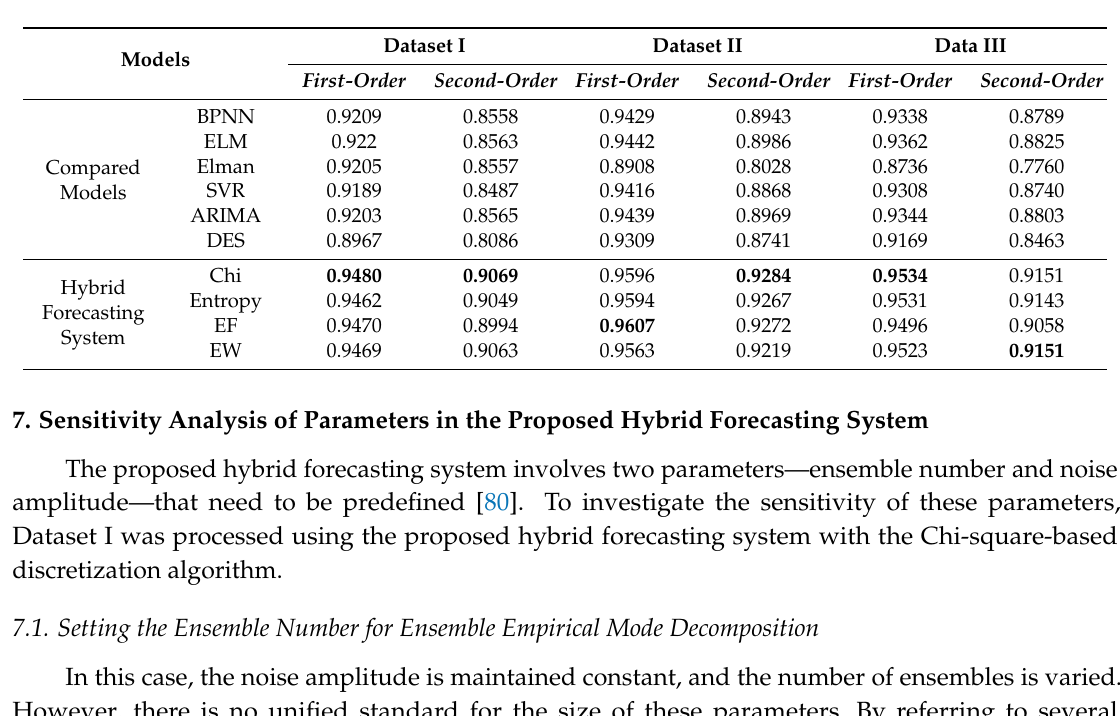
Table 12. Forecasting effectiveness of different models for the three